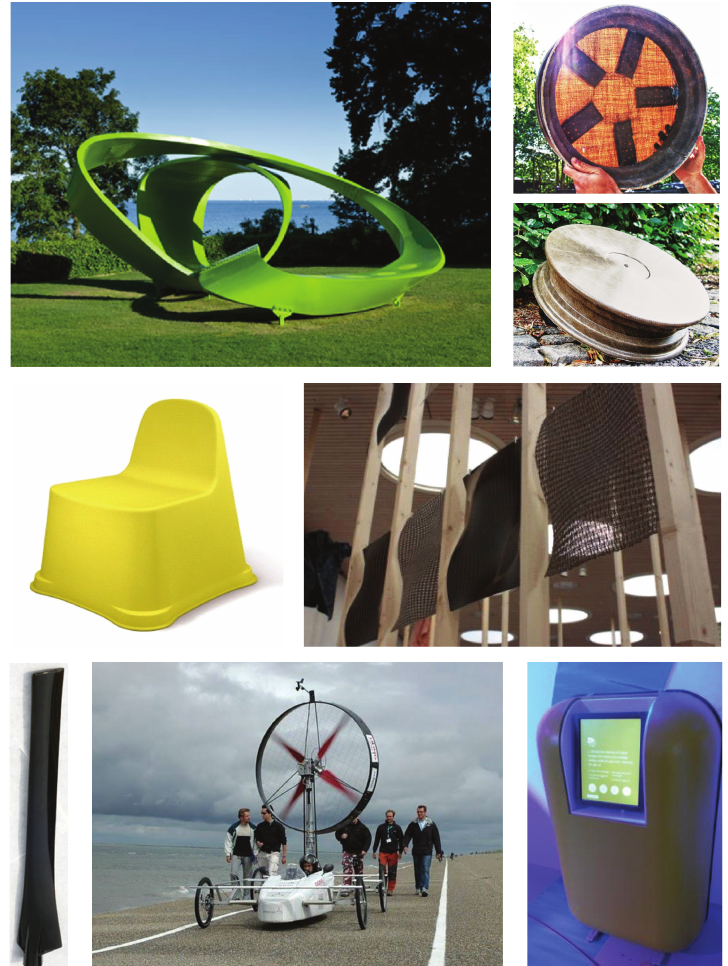
Figure 9: Examples of new applications of cellulose fiber composites: (top, left) sculpture, (top, right) wheel rim, (middle, left) chair for children, (middle, right) double-curvature panels, (bottom, left) small-scale rotor blade, and (bottom, right) exhibition stand. See text for more